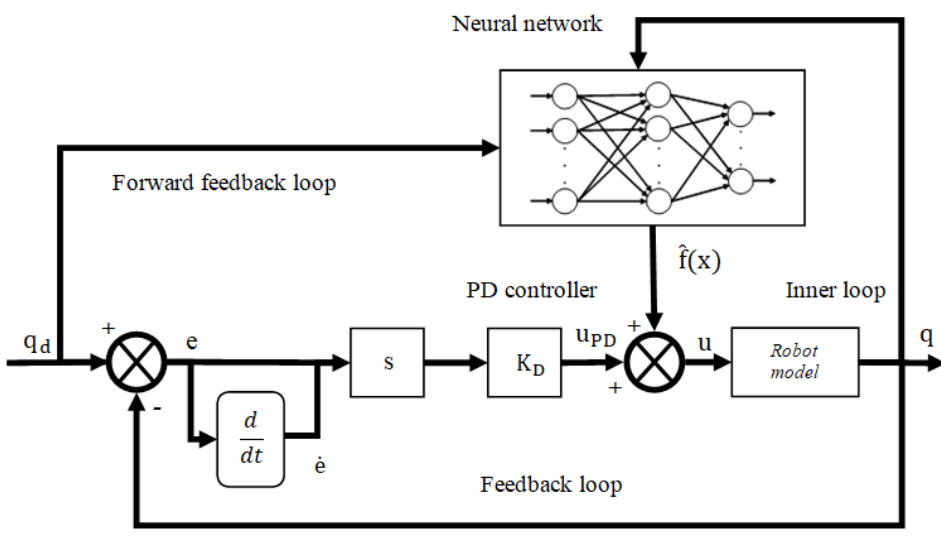
Figure 3. Diagram of the intelligent control algorithm.